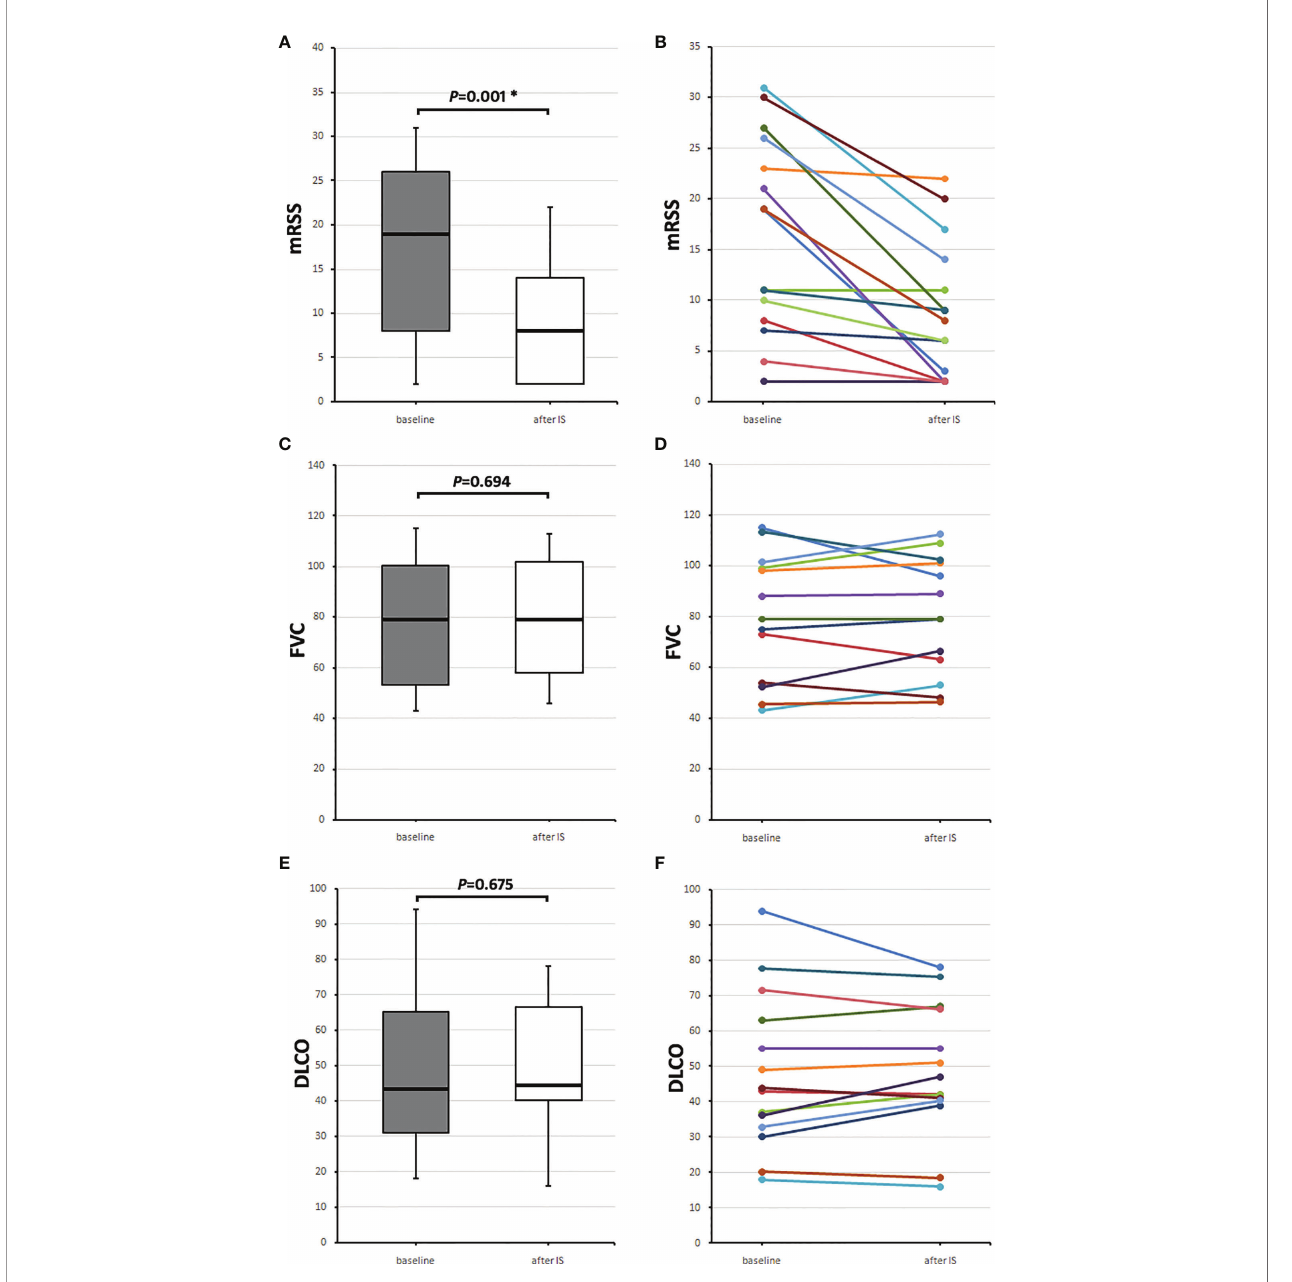
FIGURE 1 | Course of skin and lung parameters of the 16 SSc patients receiving any immunosuppressive medication (IS) after aHSCT. Baseline values (gray boxes) were taken when IS was initiated and follow-up values (after IS, white boxes) 2 years later. (A) Median modi fi ed Rodnan skin score (mRSS) values and (B) individual mRSS values, (C) median forced vital capacity (FVC) in percentages of predicted, and (D) individual FVC values, and (E) median diffusion capacity for carbon monoxide (DLCO) in percentage of predicted with (F) individual DLCO values. Box plots show medians with interquartile range, whiskers indicate minimums and maximums; *signi fi cant ( p < 0.05) difference compared to baseline in a Wilcoxon signed-rank